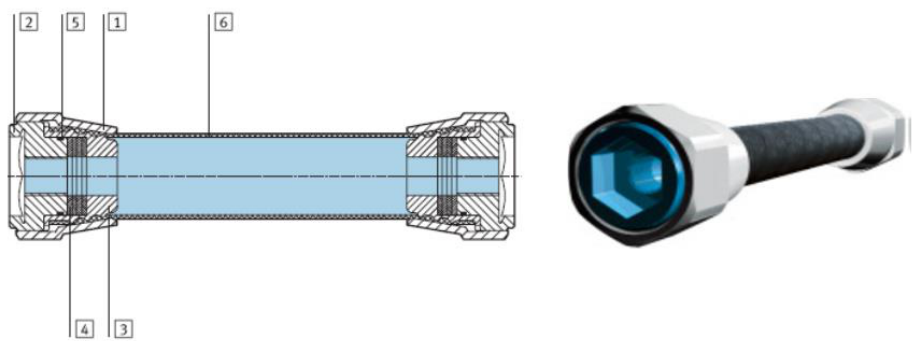
Figure 1. Pneumatic artificial muscle of MAS–20 type ( 1 ) connecting matrices (wrought aluminium alloy); ( 2 ) flange (wrought aluminium alloy); ( 3 ) internal cone (wrought aluminium alloy); ( 4 ) disc springs (steel); ( 5 ) sealing ring (nitrile rubber); ( 6 ) tube (chloroprene and aramid) [33].